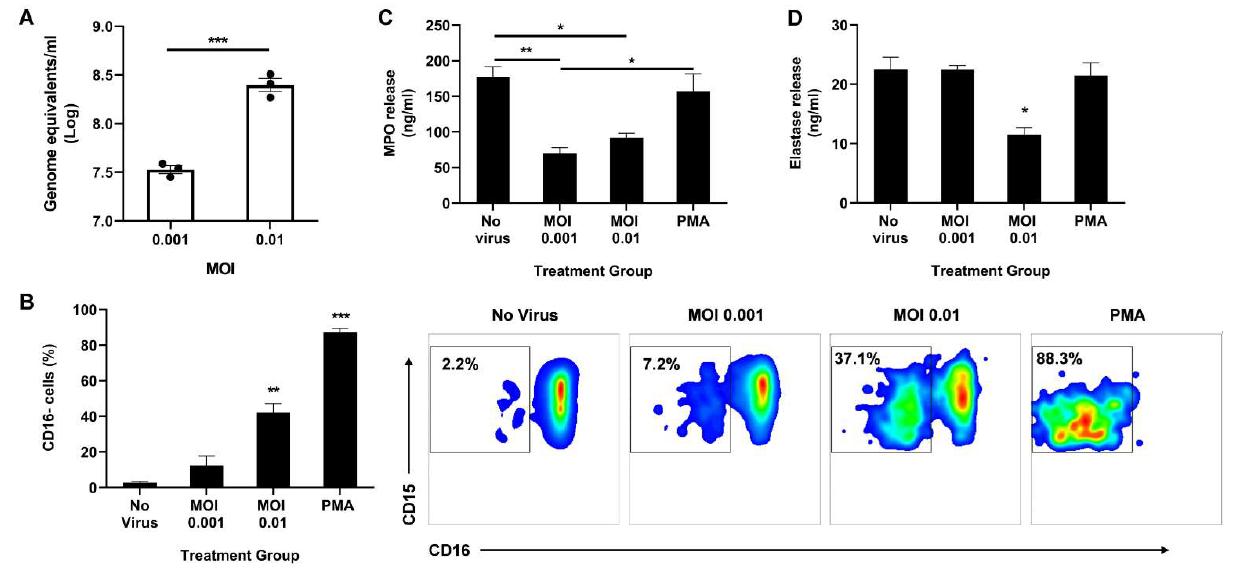
Figure 2. Direct infection of neutrophils with SARS-CoV-2 promotes CD16 shedding without increasing MPO or elastase release. ( A ) Viral titer in the neutrophils 2 h post infection; ( B ) Percentage of CD16 cells among CD11b+ CD66b+ CD14 − CD15+ population (left). Representative flow cytometry density plots of CD11b+ CD66b+ CD14 − CD15+ CD16 − cells in different treatment groups (right); Levels of MPO ( C ) and neutrophil elastase ( D ) in the supernatant media determined through ELISA. Data shown are mean ± SEM; n = 3 per group in each experiment per donor; experiments were repeated three times with three different donors; * p < 0.05, ** p < 0.01, *** p < 0.001 (Student’s t-test or one-way ANOVA with Tukey’s post hoc test).